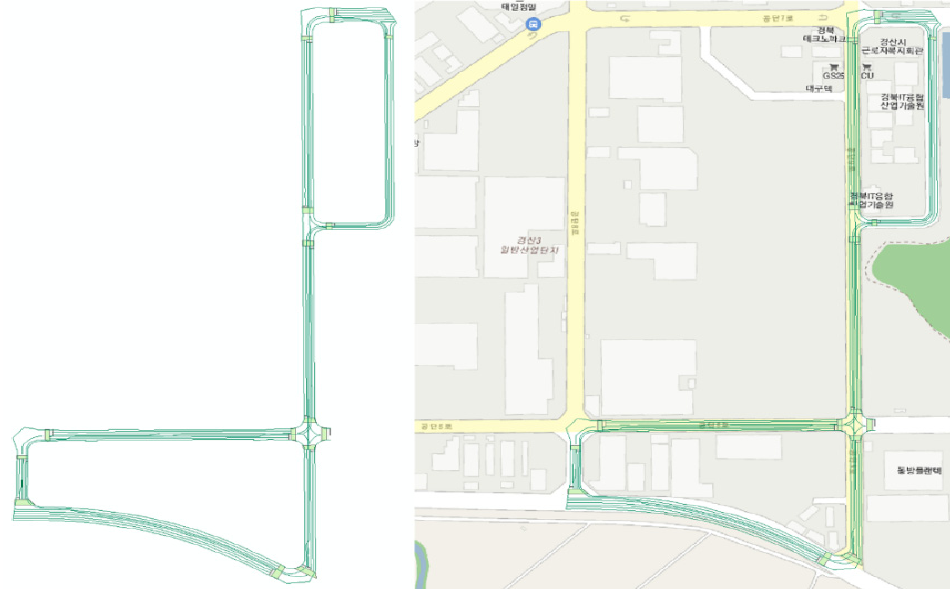
Figure 11. Dynamic high-definition map result in an industrial park.